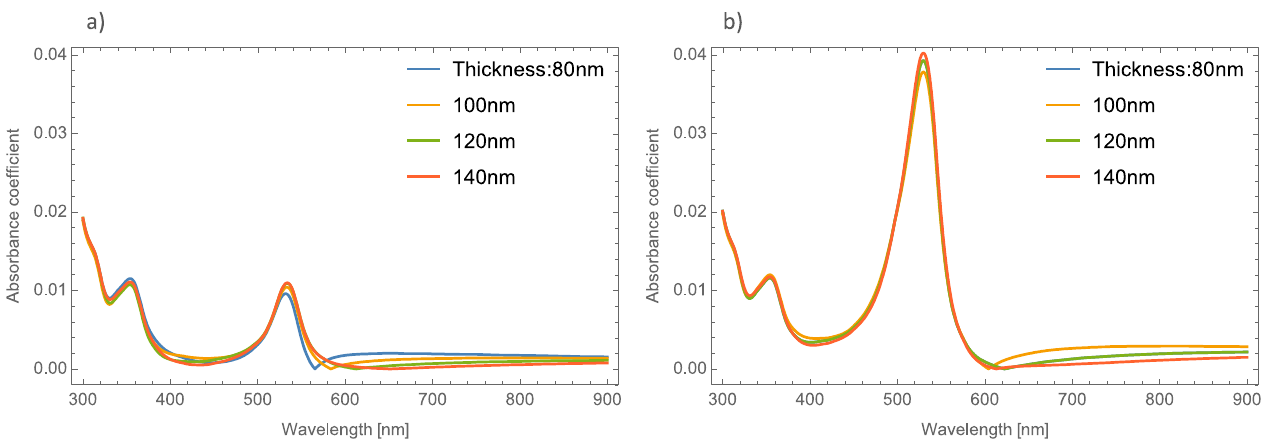
Figure 3. Absorbance coefficient of the MoO 3 thin film doped with Ag ‒ NPs of radius of 5 nm, ( a ) volume filling fraction of Ag– NPs is 1% and ( b ) the volume filling fraction of Ag– NPs is 5%. The different thicknesses are labeled.